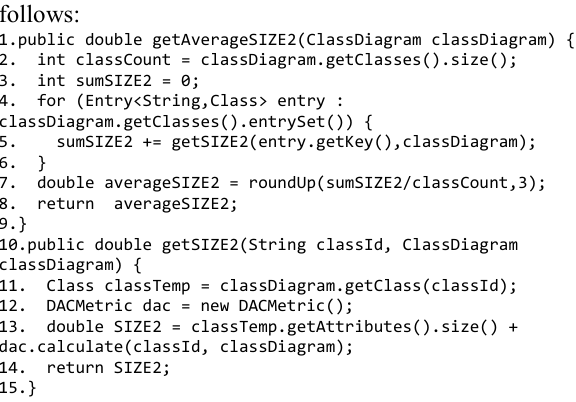
Fig. 11. The value of the execution time was calculated